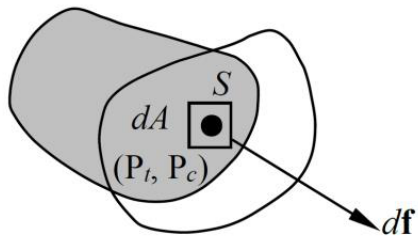
Figure 1. Contact force evaluation in the 2D FDEM. The subscripts ‘t’ and ‘c’ refer to the target and the contactor, respectively. d f t and d f c are defined in Equations (4) and (5),